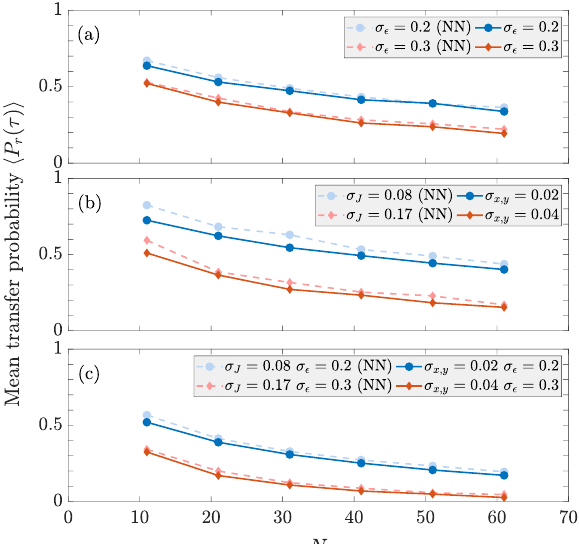
〉 vs chain length N , obtained upon Figure 6: Mean excitation transfer probability 〈 P r averaging over 1000 independent realizations of disordered chains with long-range exchange interactions (solid lines with filled circles and diamonds) and nearest- neighbor interactions (dashed lines with light filled symbols), for (a) energy (diago- nal) disorder with standard deviations σ ε , (b) position (off-diagonal) disorder with standard deviation σ or σ , and (c) combination of energy and position disorder. (cid:112) x , y J = 0.49 J / N having We use the static couplings of the sender and receiver spins J s , r = − 0.22 J ( ε = 0 for the nearest-neighbor interacting chains), and the energies ε s , r s , r evolution is terminated at t = τ of Fig.